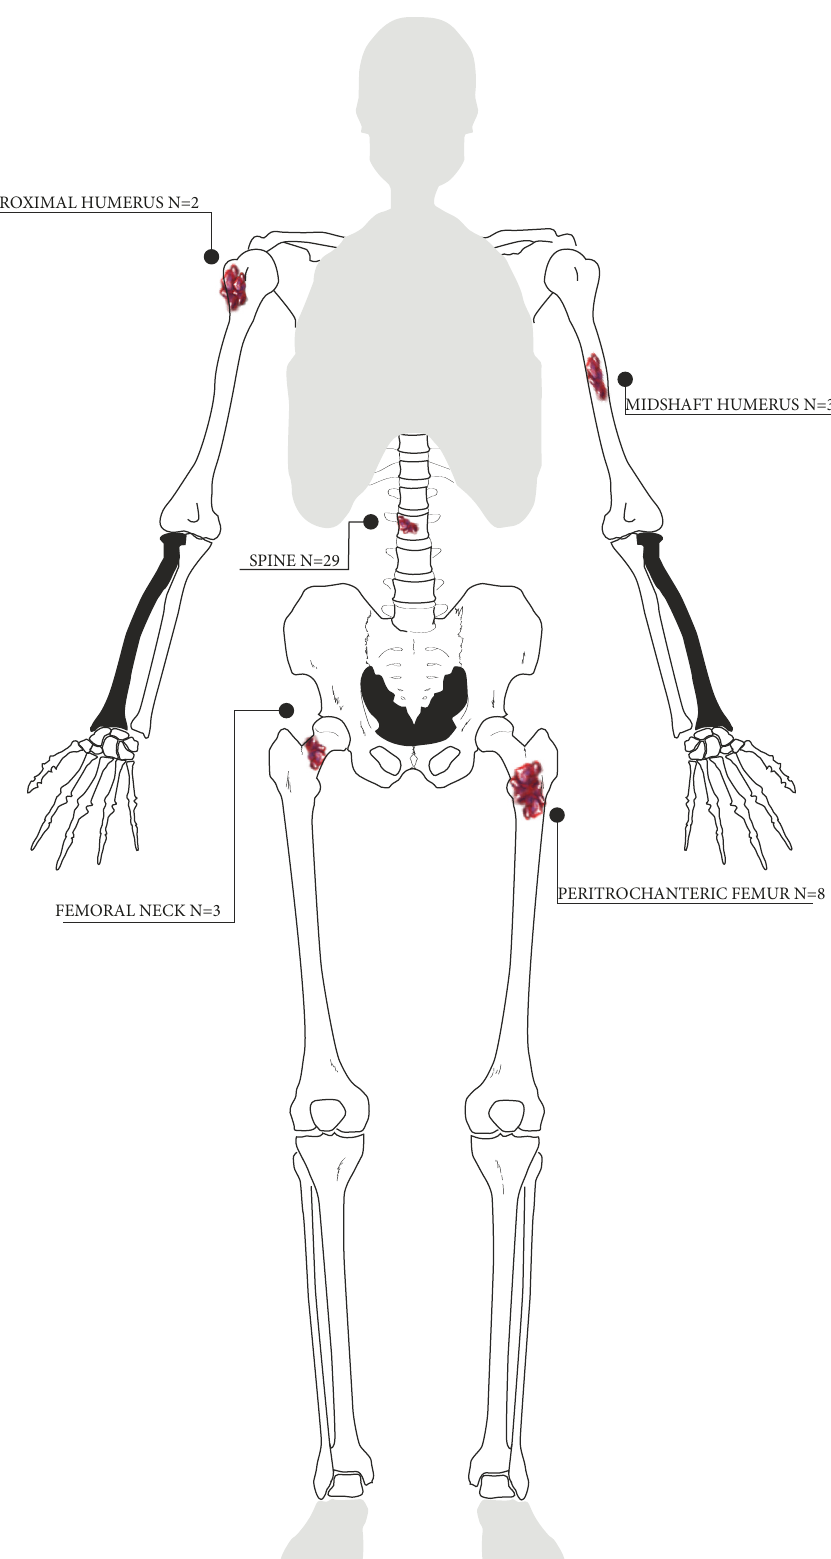
Figure 1: Anatomic locations of bone metastases in leiomyosarcoma